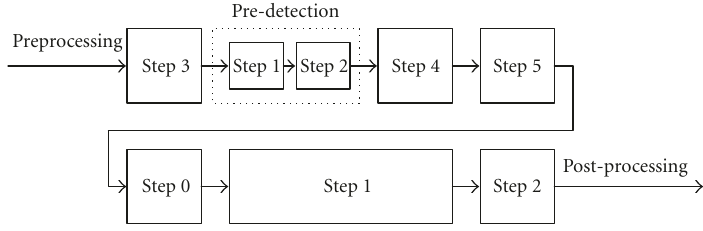
Figure 6: Illustration of block diagram of the processing without cube delay.